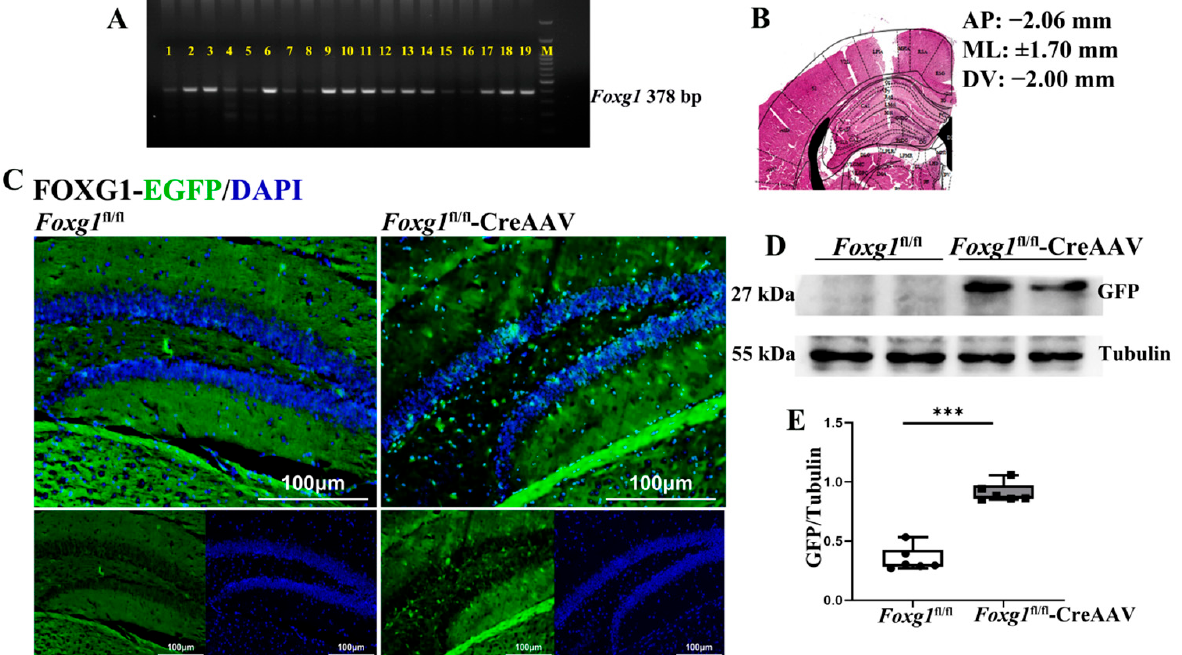
Figure 1. rAAV2/9 forces FOXG1 overexpressed in adult hippocampal DG of the Foxg1 mice. ( A ) Genotypes of the Foxg1 fl/fl offspring were determined by PCR analysis using the primers